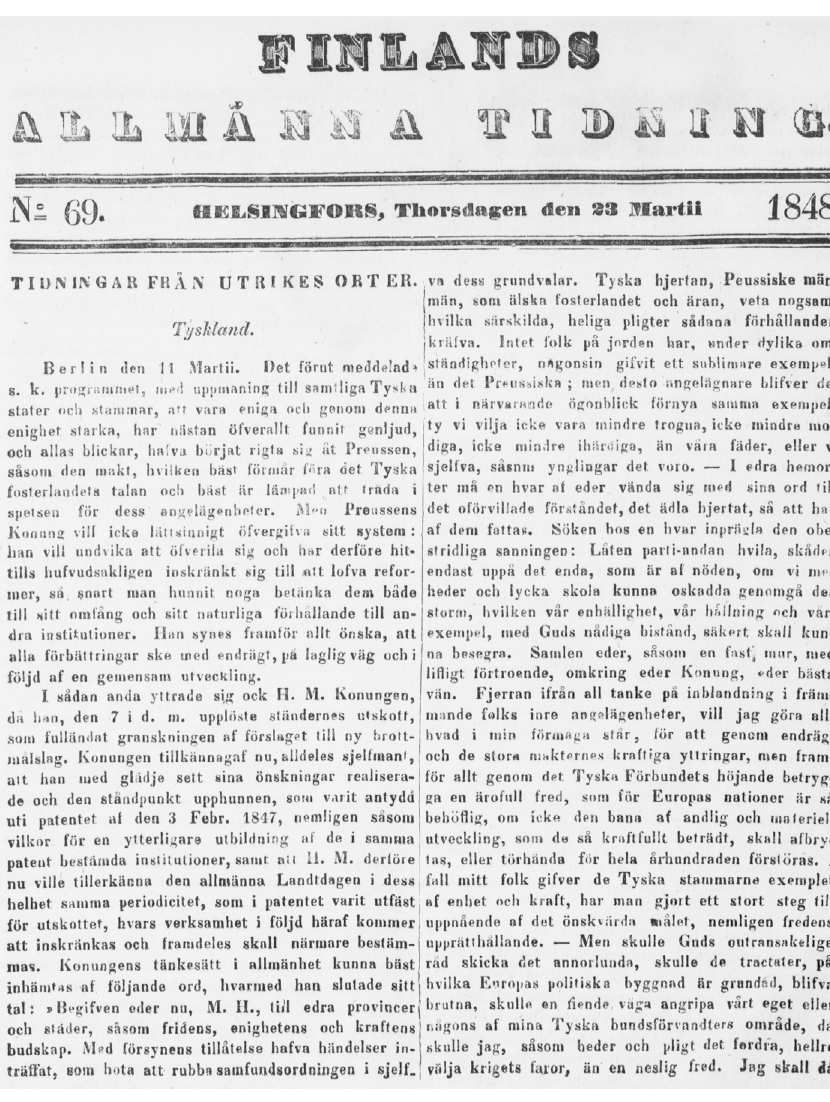
Fig. 2 Front page of the Finlands Allmänna Tidning (23 March 1848), National Library of